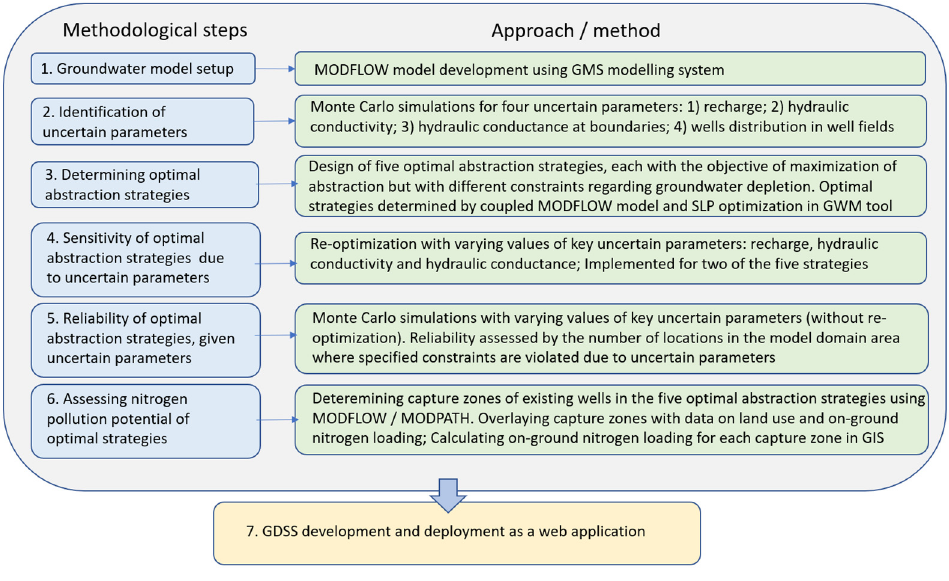
Figure 1. Overall framework with individual methodological steps.